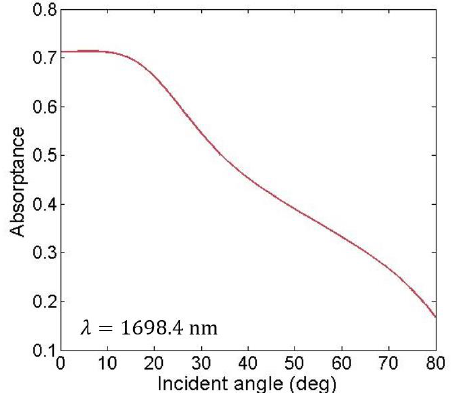
Figure 3. Absorptance of the lossy all-dielectric 1-D PC (AB) 10 as a function of the incident angle at the short-wavelength band edge λ = 1698.4 nm under TM polarization.